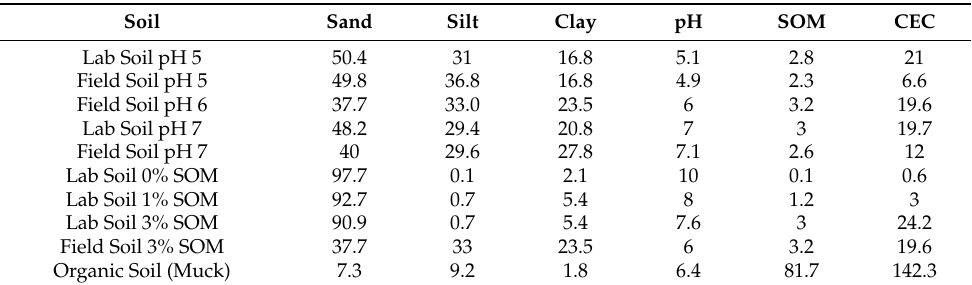
Table 3. Properties of the tested lab and field soils to evaluate the effect of soil organic matter and pH on flumioxazin residual control on Abutilon theophrasti , Amaranthus retroflexus , Chenopodium album , and Setaria faberi a .